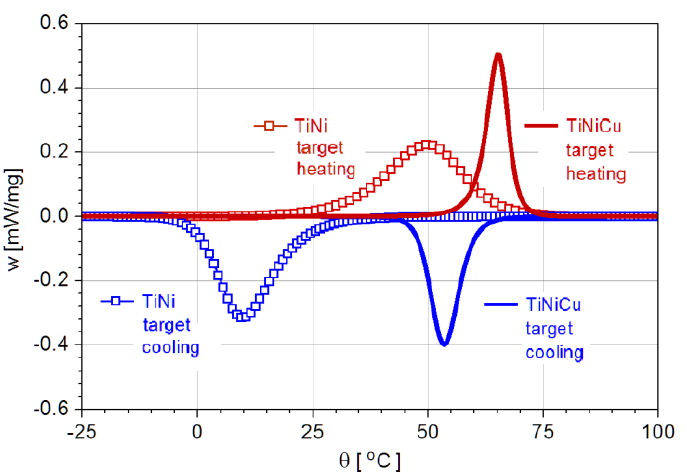
Figure 4. DSC records of the MPT in the target alloys used for experiments: Ti-Ni, showing the B2 → B19’ transition, and Ti-Ni-Cu, showing the B2 → B19 transition.